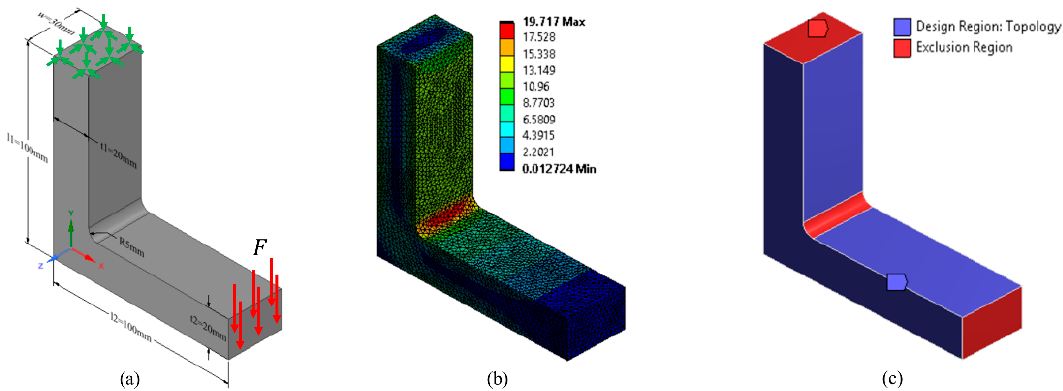
Figure 14. ( a ) The initial design of the L-Bracket, as well as the finite element model, ( b ) the FEA of the L-Bracket ( σ max = 19.7 MPa), and ( c ) the design space for the TO. Table 4. The used design parameters (factors) in the optimization of the L-Bracket, their description, initial value, allowable range, and value increment (step) in